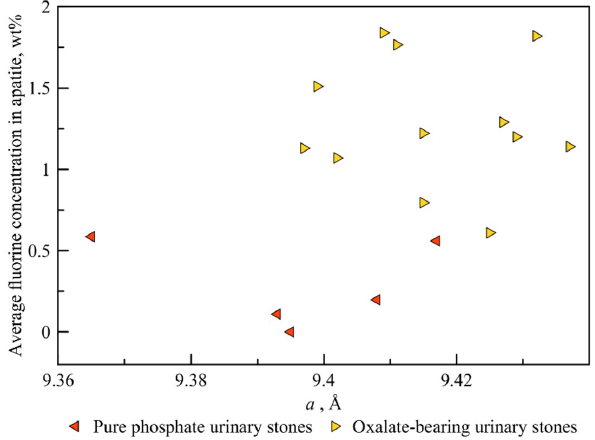
Figure 8. The plot of the a unit cell parameter values of the kidney stones’ apatite versus its fluorine content (wt%).